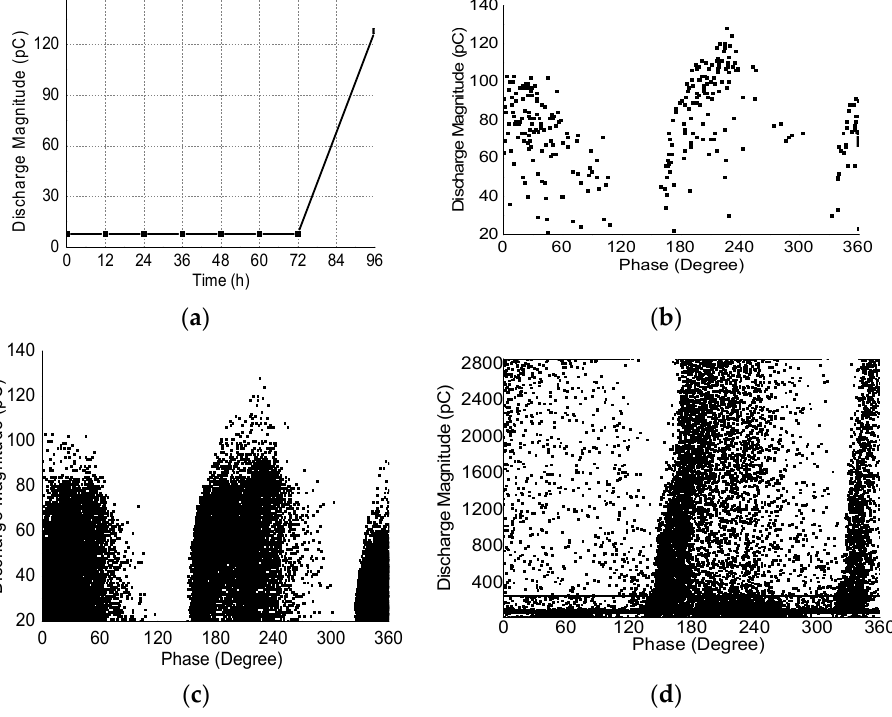
Figure 7. Spectra of PD at different time intervals. ( a ) Change of PD magnitudes; ( b ) 1 min; ( c ) 30 min; ( d ) 31 min.